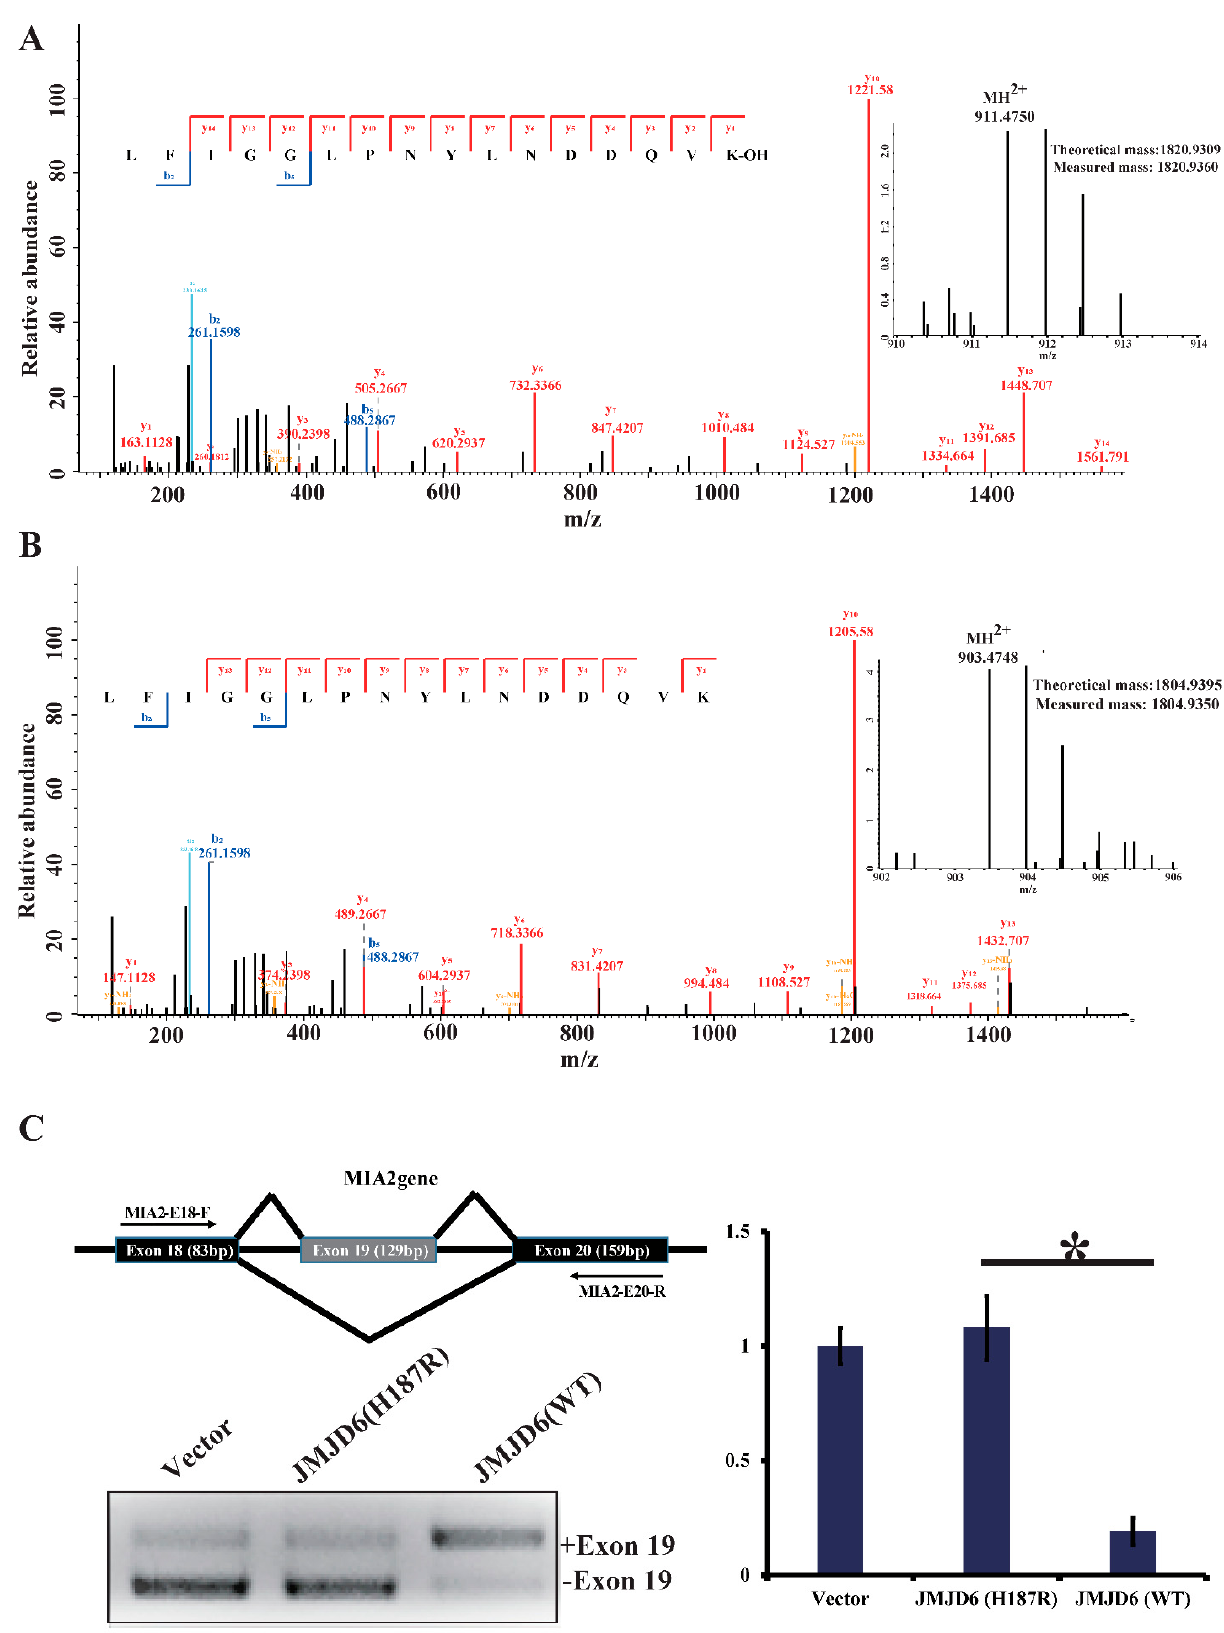
Figure 3. JMJD6 (H187R) abolishes the lysyl-hydroxylation of U2AF65 and influences mRNA splicing. ( A , B ) MS/MS analysis of recombinant U2AF65 reveals the hydroxylation of Lys-276 ( A ) by JMJD6 (WT) and no hydroxylation of Lys-276 ( B ) by JMJD6 (H187R). Recombinant U2AF65 was incubated with recombinant JMJD6 or recombinant JMJD6 (H187R) in the presence of 2-OG (500 µM) and Fe(II) (400 µM) for 2 h at 37 °C. The assay mixture was separated in SDS-PAGE, and the band corresponding to the molecular weight of GST-U2AF65 was excised, digested, and then analyzed. Data for the